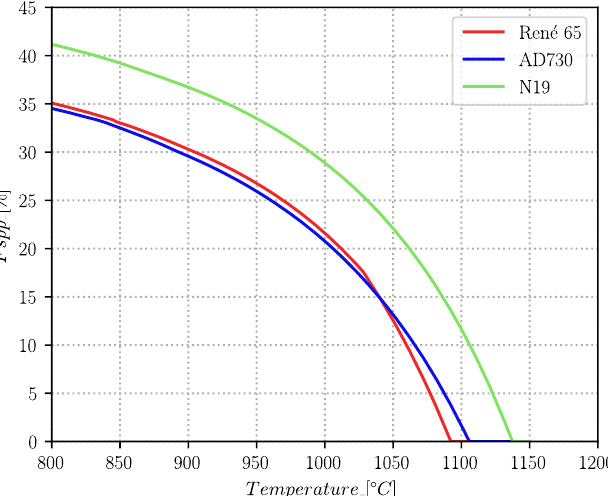
Figure 2. γ (cid:48) phase volume fraction vs. temperature curves for the René 65, AD 730 and N 19 superalloys (obtained from Thermo-Calc